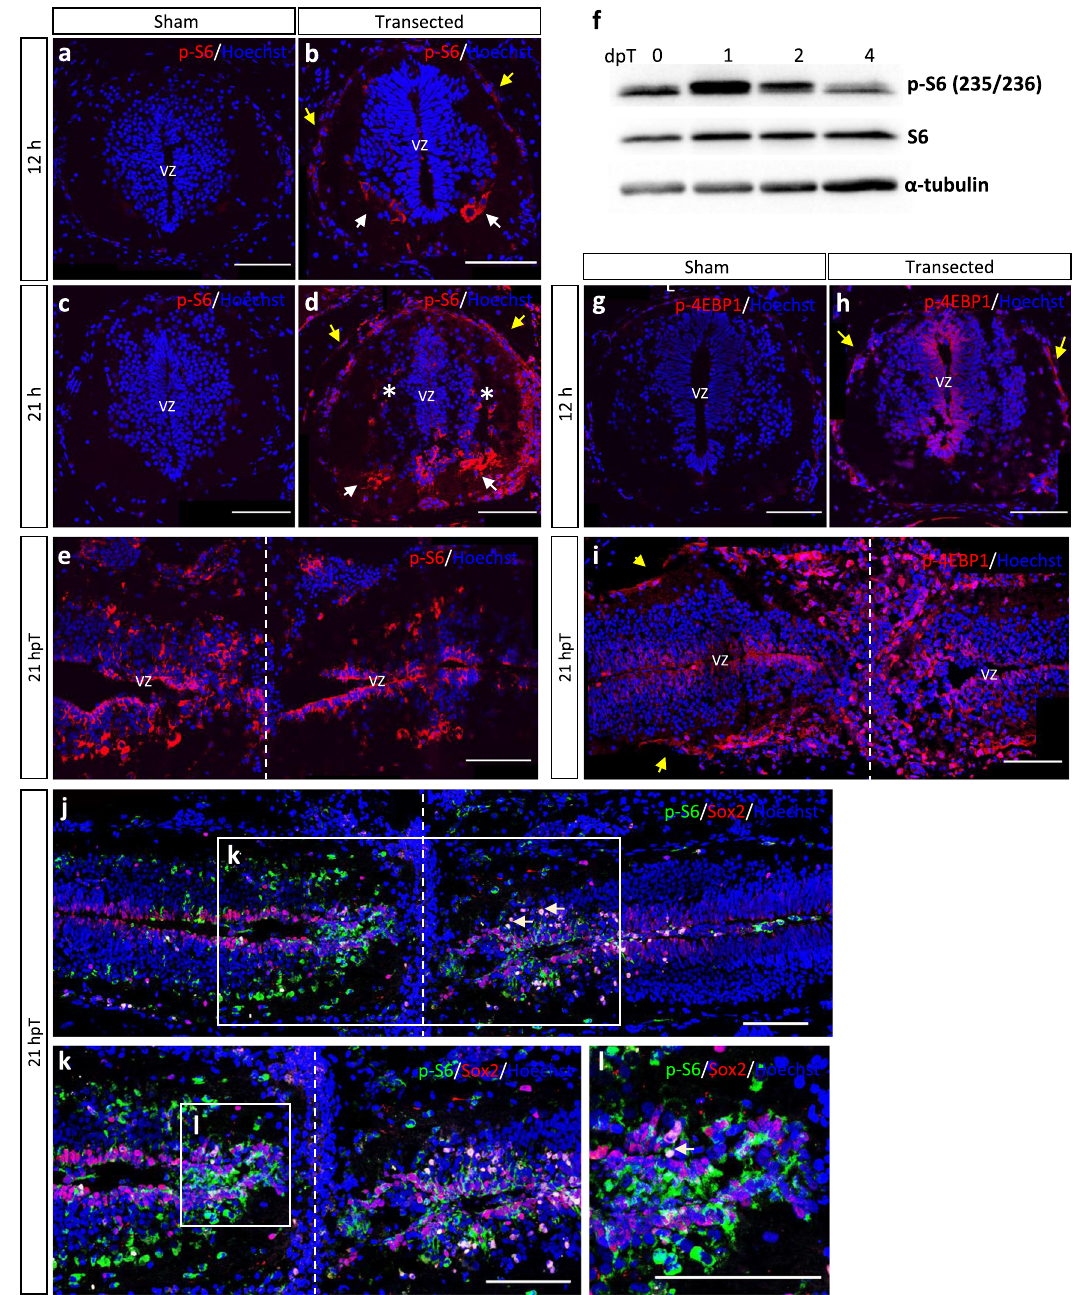
Fig. 4 Early activation of mTOR signaling in response to SCI. Activation of mTORC1 was analyzed by immunostaining ( a – e ) and immunoblotting ( f ) for p-S6, by immunostaining ( g – i ) against p-4EBP1, and ( j – l ) double immunostaining for Sox2 and pS6. p-S6 levels were analyzed in transverse cryosections at ( a , b ) 12 and ( c , d ) 21 h after transection or sham operation and also in longitudinal cryosections at ( e ) 21 hpT. f Western blot for S6 and p-S6 in total protein extracts obtained from spinal cords at 0, 1, 2, and 4 dpT for evaluation of mTOR signaling pathway activation after injury. See quanti fi cation of fi ve similar blots in Supplementary Fig. S3a. p-4EBP1 levels were analyzed in transversal cryosections at ( g , h ) 21 h after transection or sham operation and also in longitudinal cryosections at i 21 hpT. Yellow arrow: meningeal cells, white arrow: motoneurons, *: lateral neurons, vz: ventricular zone, dotted line: injury site or ablation gap. Sox2 and p-S6 were analyzed in longitudinal cryosections ( j ), and ( k , l ) correspond to magni fi cations of ( j , k ), respectively. White arrows show Sox2 + cells with higher levels of p-S6 activation. Immuno fl uorescences were performed in two or three biological replicates. Scale bar = 100 μ m. All the blots included in this fi gure were derived from the same experiment and were processed in macrophage polarization after SCI, regulating pro- and anti- GO terms, we found irs4, which inhibits JAK/Stat signaling in fl ammatory response 34 . This analysis suggests that there is an pathway, modulating the immune response 32 ; PDE5A (phospho- diesterase 5A), whose pharmacological inhibition have been active mechanism to control and limit the immune response. associated with anti-in fl ammatory and neuroprotective effects 33 ; We observe an enrichment in genes associated with “ regulation of extrinsic apoptotic signaling pathway ” in module E2; however, and shh (sonic hedgehog), which has been implicated in